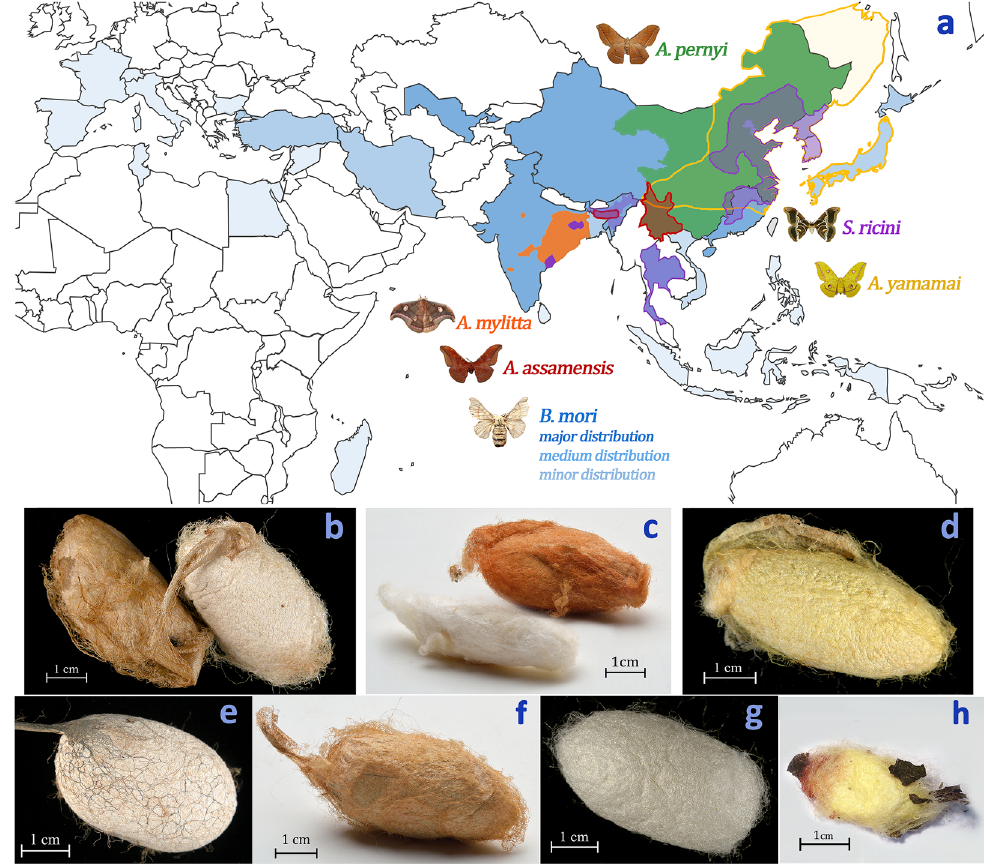
Figure 1. Distribution of silk moths by their indigenous habitats (a) and their cocoons (b–h) . (a) Areas marked in colors correspond to habitats of silk moths: green— A. pernyi (b) is indigenous to southern China but was introduced to sub-tropical and tropical Asia for wild silk production; purple— S. ricini ( c ) is indigenous to Korea and eastern China, though it naturally spread to parts of India and was introduced to Thailand in